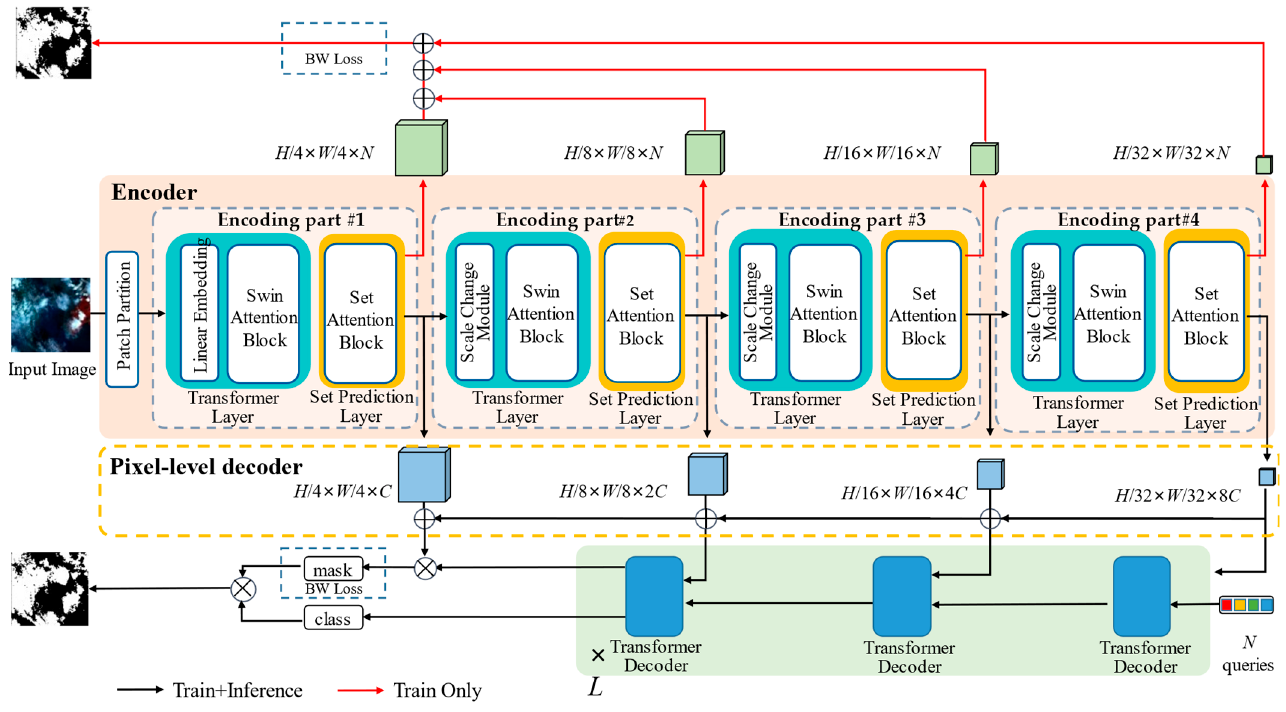
Figure 1. The overall structure of Cloudformer V2.